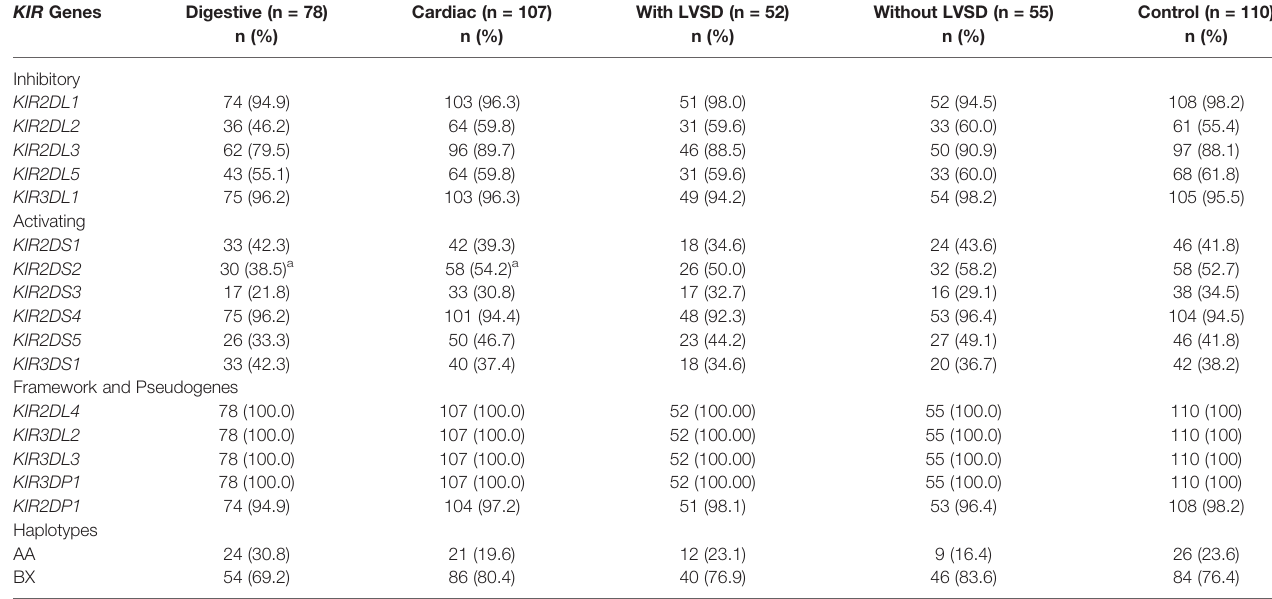
TABLE 4 | Distribution of KIR genes and KIR haplotypes in patients with the digestive or cardiac forms of chronic Chagas disease and, in patients with LVSD and without LVSD and in control individuals. KIR Genes Digestive (n = 78) Cardiac (n = 107) With LVSD (n = 52) Without LVSD (n = 55) Control (n = 110) n